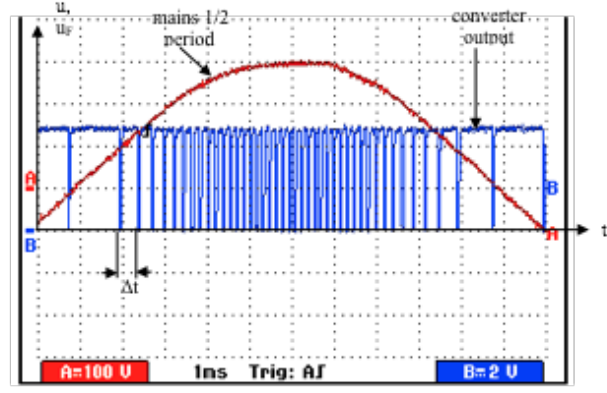
Fig. 3. Example of voltage dependent sampling rate operation.